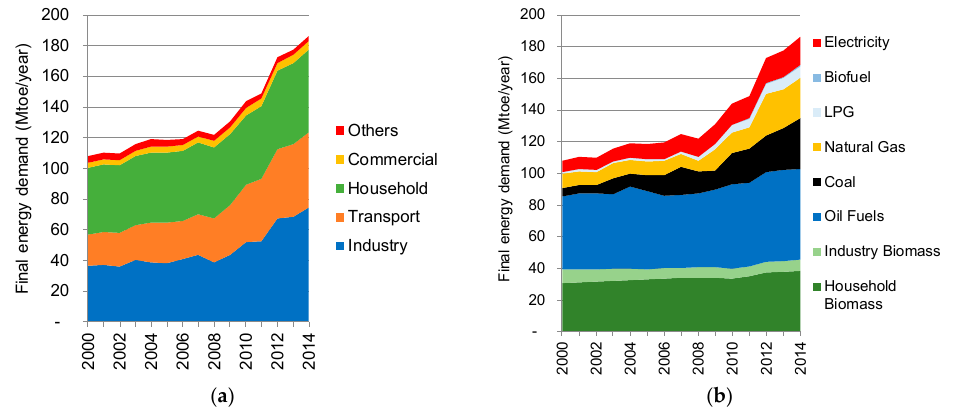
Figure 1. Current energy demands and a breakdown of trends [8]. ( a ) Total energy demands by sector; and ( b ) Total energy demands by fuel type. Mtoe: million tons oil equivalent.